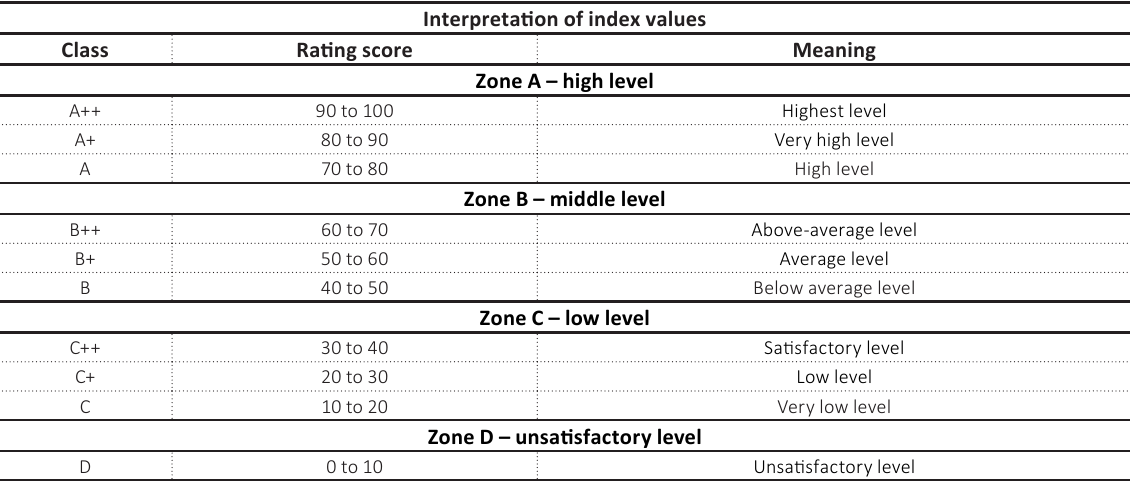
Source: Compiled by the